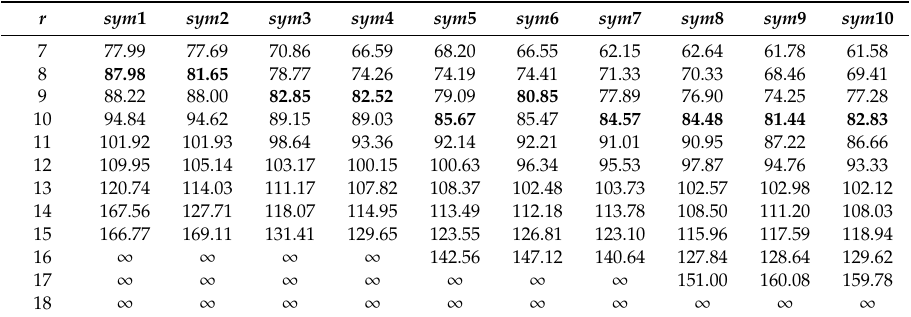
Table 23. Experimental results ( PSNR , dB) of 3D tomographic 16-bit image “Body_1.0” DWT by using bit-width r of symlets filters coe ffi cients.